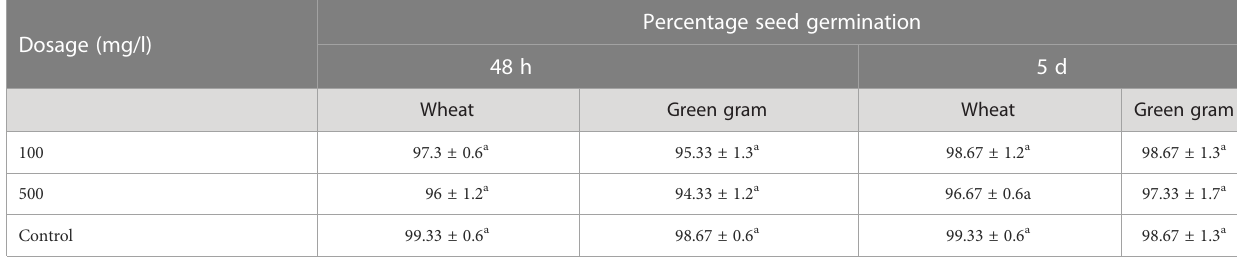
TABLE 3 Effect of the enriched fraction on seed germination of wheat and green gram.